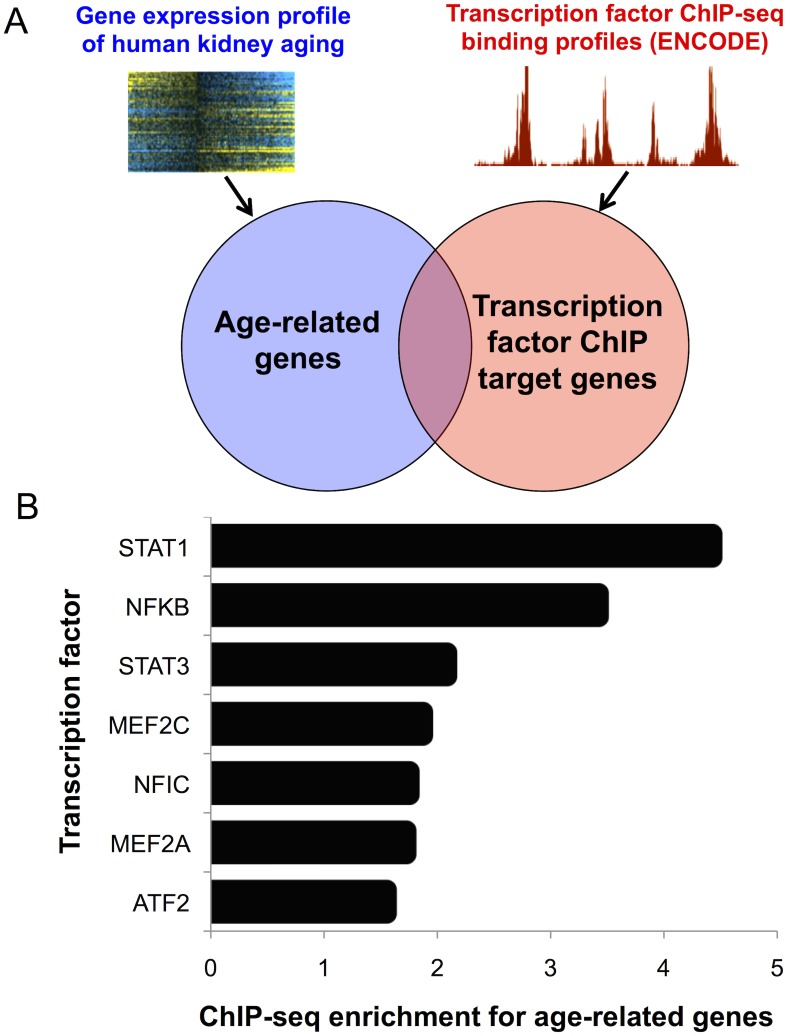
Genomic search for candidate regulators of the kidney aging transcriptome.A. Schematic of the genomic pipeline used to identify associations between transcription factor ChIP-seq binding targets (ENCODE) and kidney age-related genes. The list of age-related genes was overlapped with the ChIP-seq binding targets of 161 transcription factors from 961 ChIP-seq experiments (see Methods). The overlap between the target genes assigned to each transcription factor with age-related genes was determined for each ChIP-seq dataset. B. The histogram shows the fold-enrichments of seven transcription factors that were >1.5 fold enriched and statistically significant after Bonferroni correction (p < 5 x 10−5) for binding the kidney age-related genes (see Methods). The three inflammation-associated transcription factors STAT1, NFκB (RelA) and STAT3 showed the strongest ChIP-seq enrichments for binding kidney age-related genes.